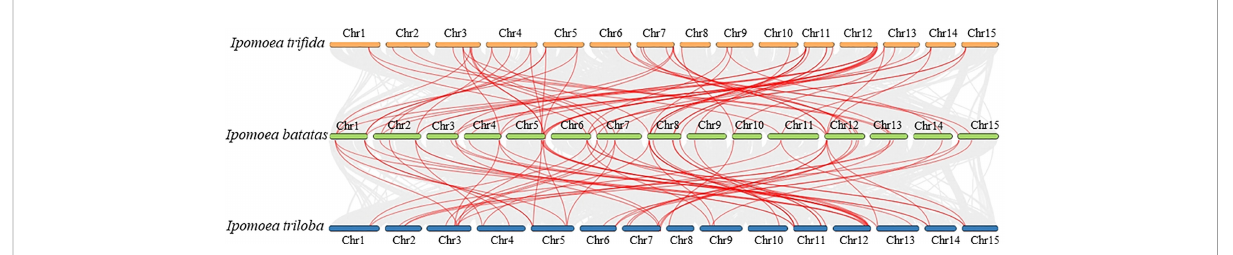
FIGURE 5 Synteny relationships of duplicated TCS genes in Ipomoea batatas , Ipomoea tri fi da and Ipomoea trilobal . Lines between the chromosomes indicate duplicated gene pairs.